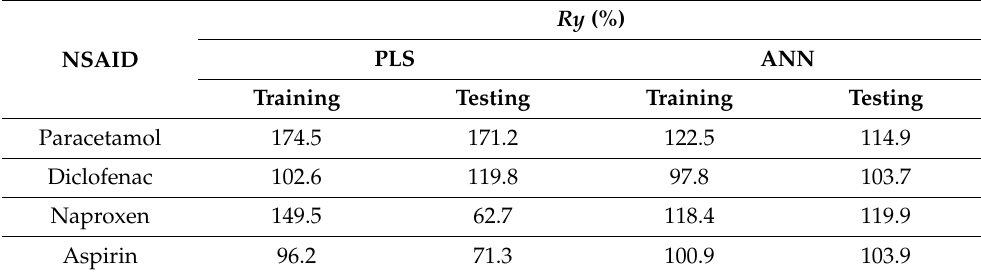
Table 5. Ry values of the variability of information for the PLS and ANN models.